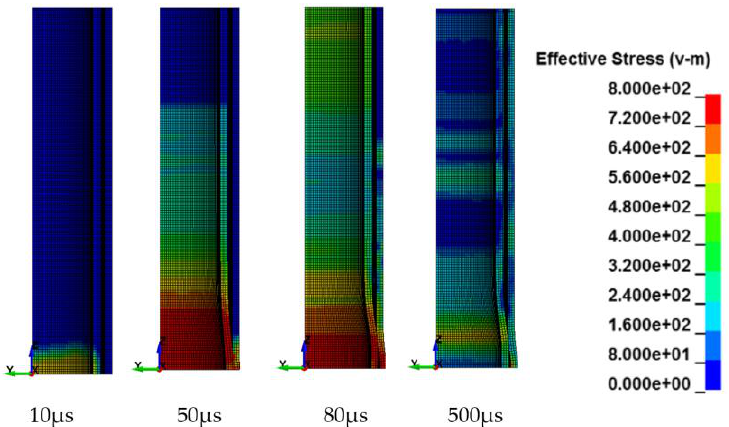
Figure 13. Stress distribution cloud of double-layer steel shells.